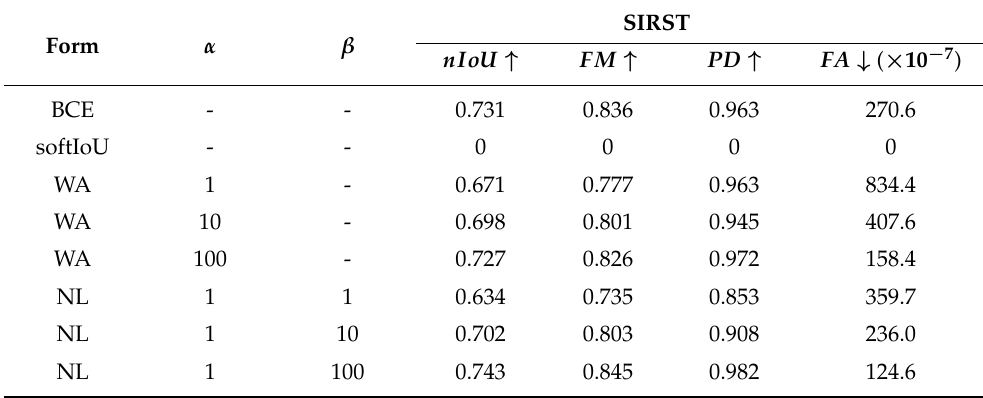
Table 8. Results of different forms of loss function combination on the SIRST dataset.